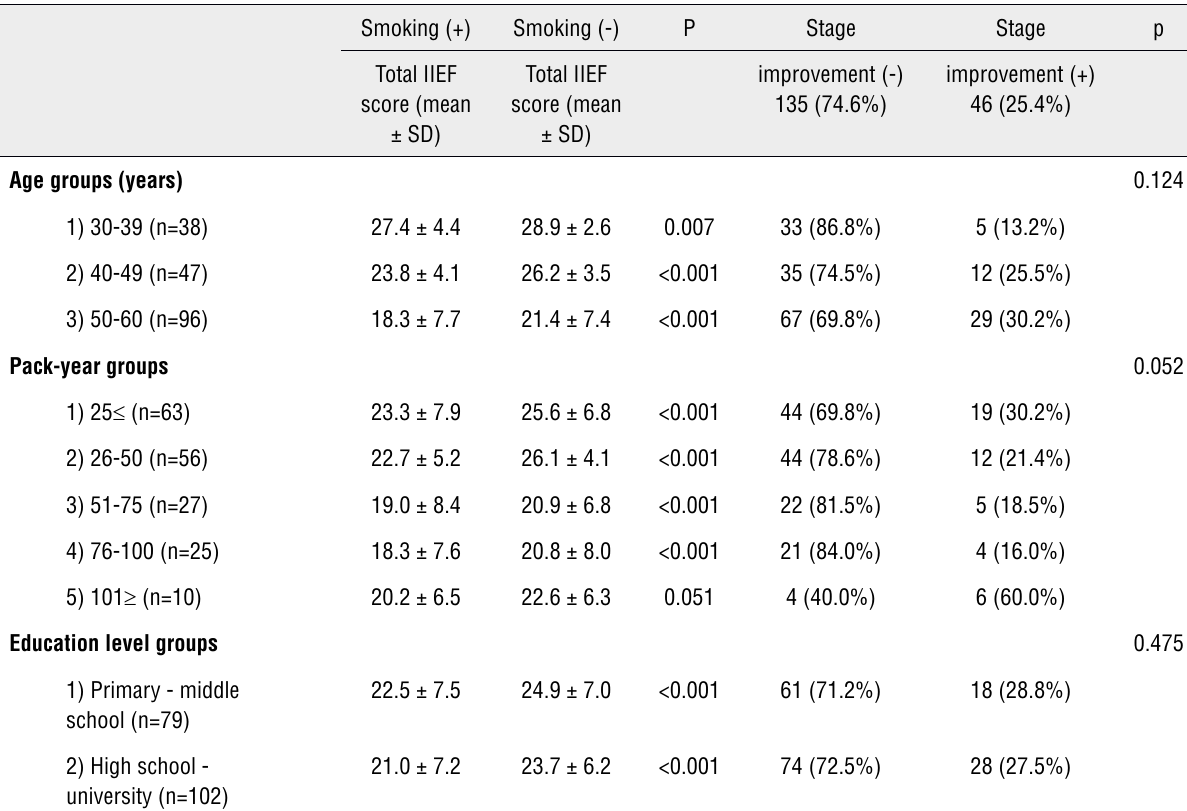
Table 1 - Comparison of the total IIEF scores and stage improvement status before and after smoking cessation in age, pack-year and education level